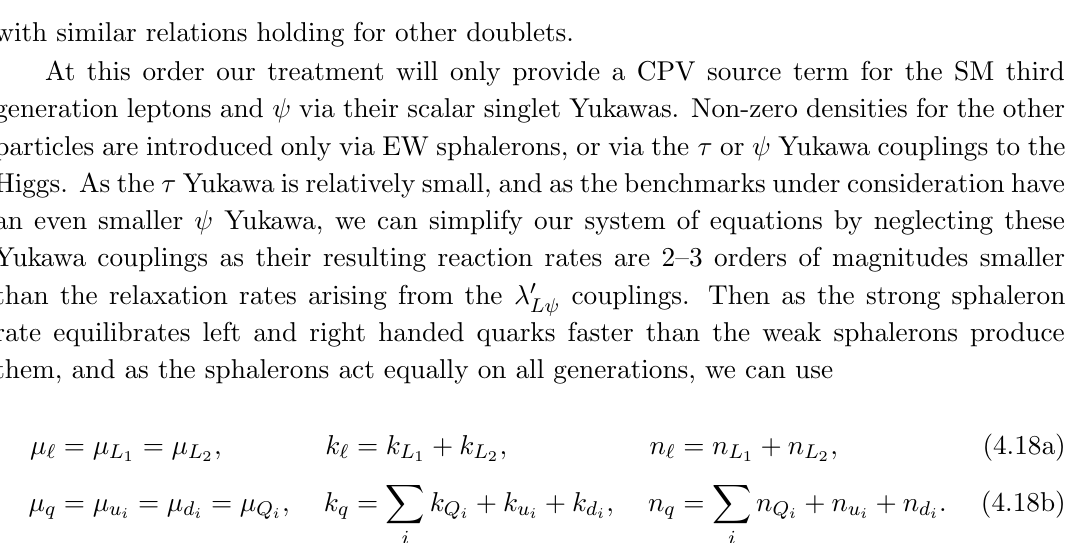
Figure 6. Self-energy diagrams that contribute terms to the transport equations, including; (a) VEV-Insertions with spatially varying VEVs that will provide a CPV source term S CPV equilibration rate (cid:0) (cid:6) acting on the fermions, and (b) Yukawa-loops which just provide an AB S i ;H equilibration rate (cid:0) AB S acting on all of the particles in the i ;H